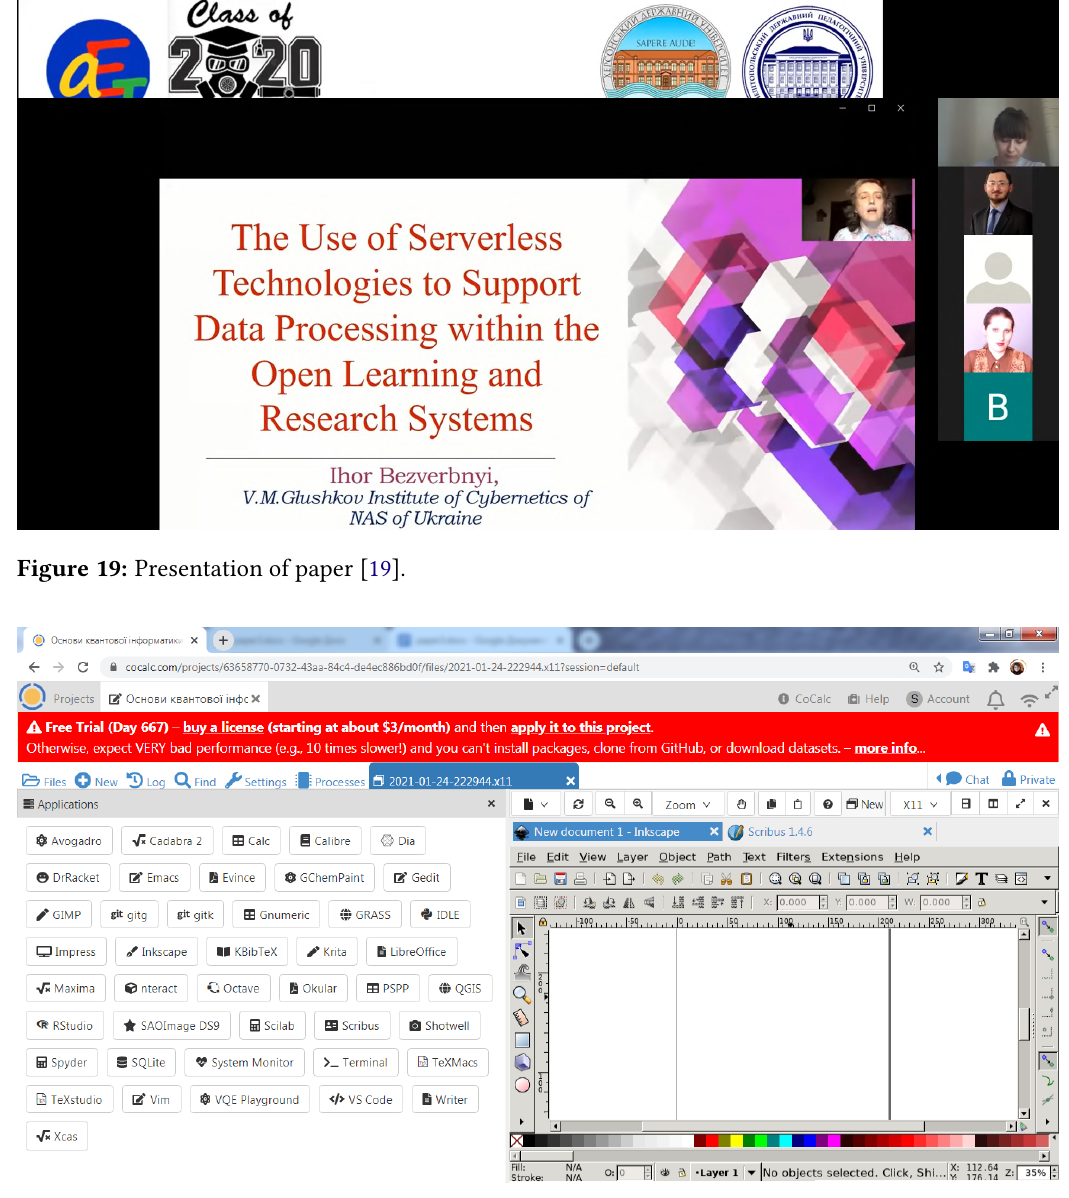
Figure 20: Presentation of paper